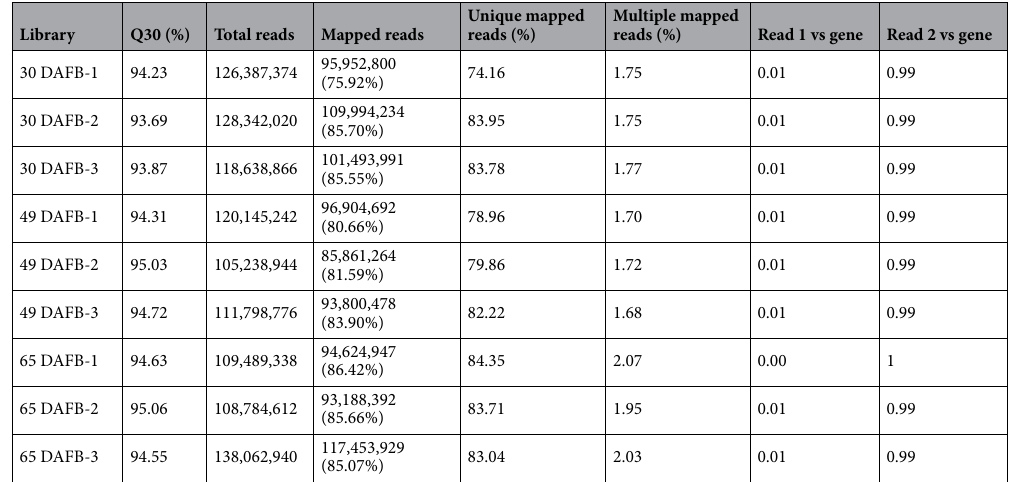
Table 1. Summary of the ssRNA-Seq data of the peach